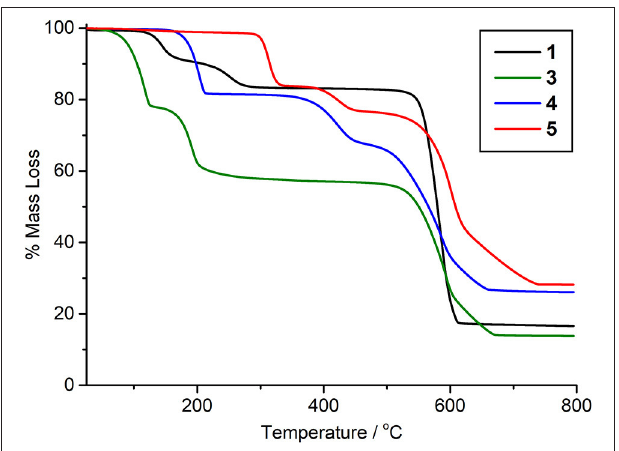
FIGURE 6 | Thermogravimetric analysis in air of 1 , 3 , 4 , and 5 .